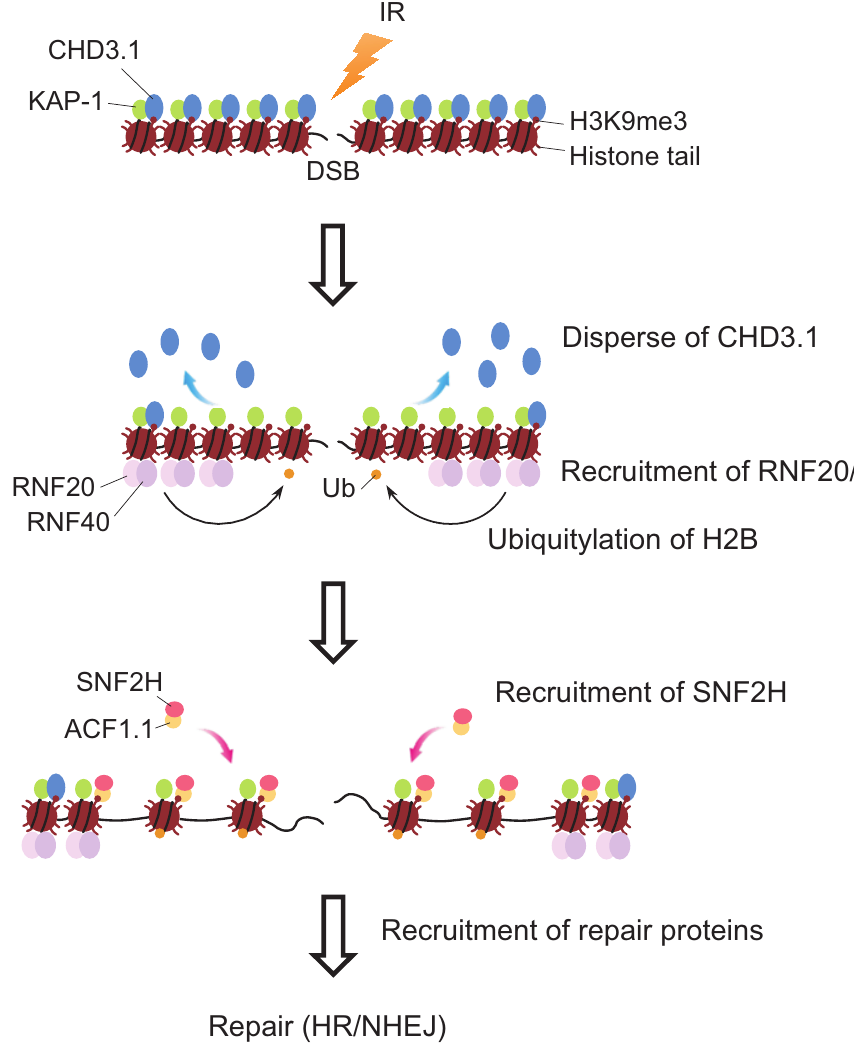
Figure 2. Model of RNF20-SNF2H pathway of chromatin relaxation in DSB repair.